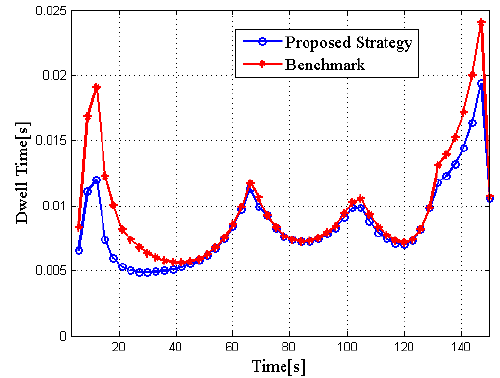
Figure 10. Comparison of total dwell time for different algorithms in RCS case 2.